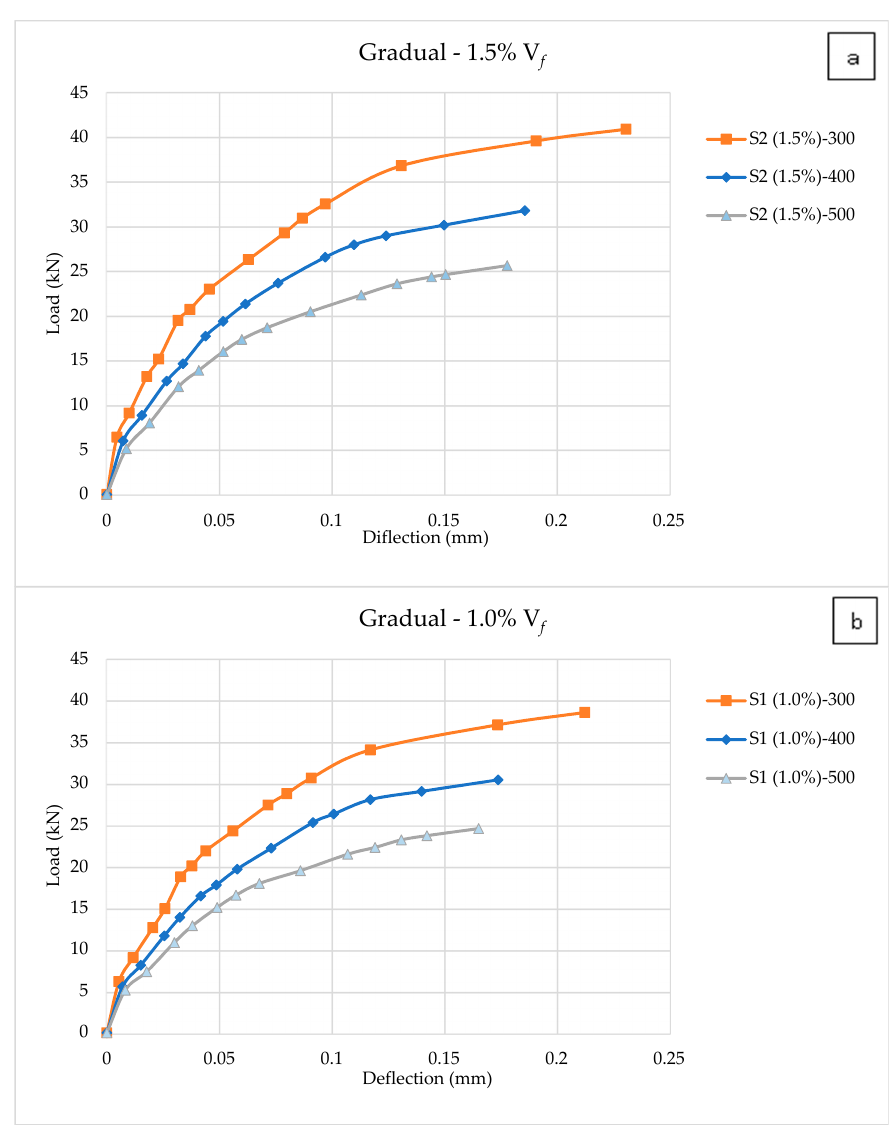
Figure 12. Load-Deflection curves concerning gradual cooling at different burning temperatures: ( a ) For 1.5% V f ; and ( b ) For 1.0% V f .